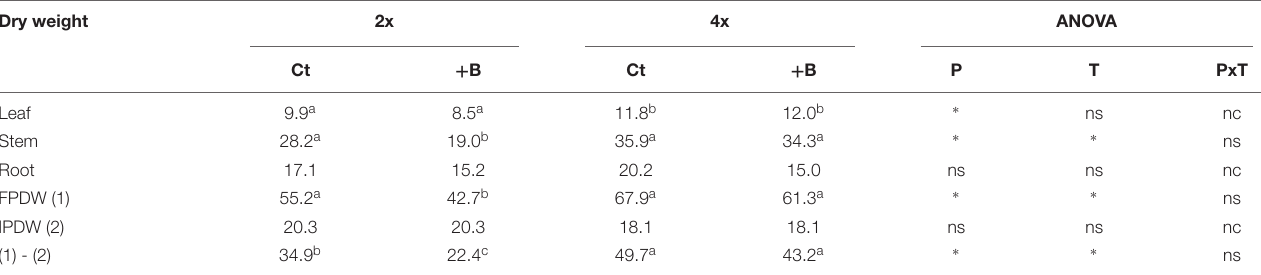
TABLE 5 | Dry weight (g) of organs and whole plant of the 2x and 4x CC seedlings grown under greenhouse conditions (Experiment 2) for 10 weeks in nutrient solutions supplemented with 50 µ M (Ct) or 800 µ M ( + B) H 3 BO 3 . Dry weight 2x 4x ANOVA Ct + B Ct + B Leaf Stem Root FPDW (1) IPDW (2) (1) - (2) The DW of fallen leaves was included in each group of plants. FPDW: DW of the whole plant at the end of treatment; IPDW: DW of the whole plant at the beginning of the treatment; (1–2): difference between the final (FPDW) and initial (IPDW) DW of plants. Values are the means of six plants (n = 6). Ploidy (P) and treatment (T) effects tested by two-way ANOVA are indicated as follows: ∗ P < 0.05; ns, not significant; nc, not considered. Different letters in rows indicate significant differences at P < 0.05 using Duncan’s multiple range test.